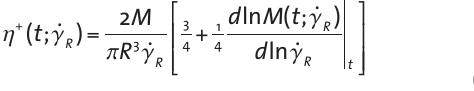
Figure 7: Comparison of strain sweeps for P-P and C&P fix- tures, using an 8.5 wt.% solution of SEP in squalane (Data are an average of five independent runs). Left: data as provided by rheometer, Right: P-P shifted by a = 3/4 ths and 4/5 ths of the rim shear strain giving the thin lines. The right-most line corresponding to the 4/5ths shift, is skimming the bottoms of the C&P symbols for G’, and thus is difficult to